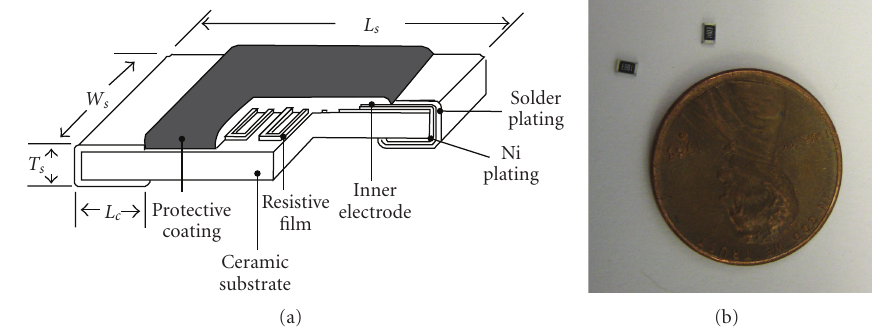
Figure 2: Schematic of the chip resistor 805, Koa Speer Electronics Inc.